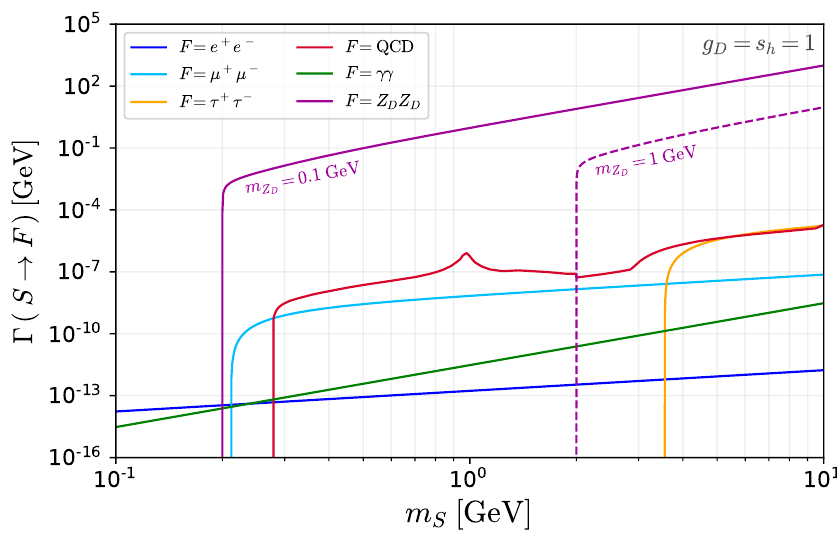
Figure 1 . Dark Higgs partial decay widths into electrons (dark blue), muons (light blue), taus (orange), light hadrons, quarks and gluons (dark red), photons (green) and dark photons (purple) with m Z = 0 . 1 GeV (solid) and m Z = 1 GeV (dashed). We fixed the couplings to g D = 1 D D and s h = 1 .